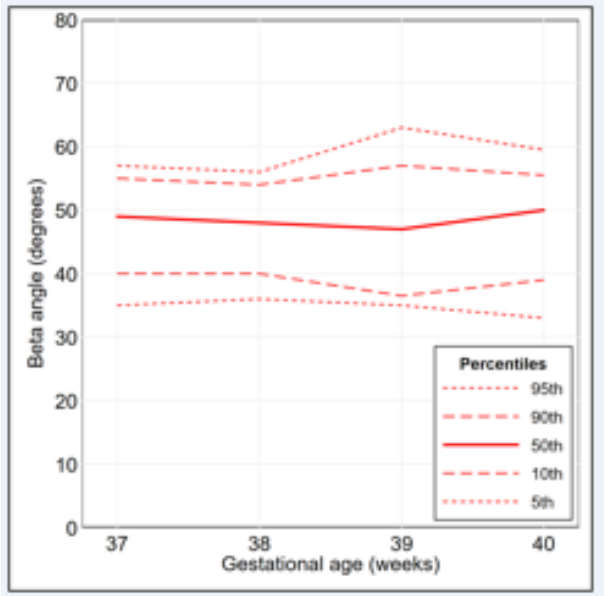
Figure 4. Alpha-angle percentile curves for gestational age 37 to 40 weeks (37 weeks: n = 131; 38 weeks: n = 101; 39 weeks: n = 100; 40 weeks: n = 100).